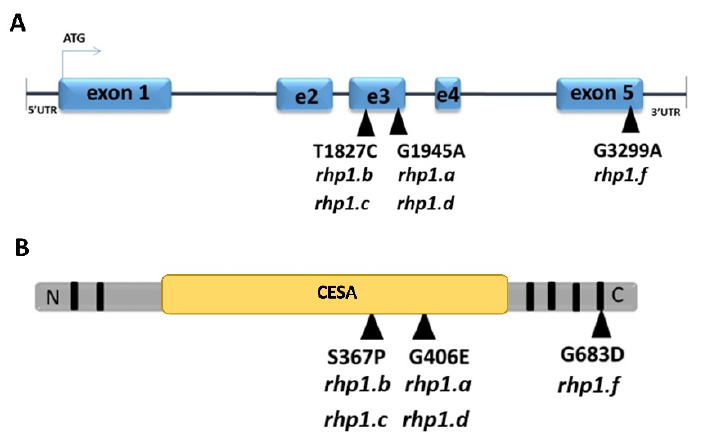
Figure 4. The location of identified mutations (black triangles) in ( A ) genomic and ( B ) protein se- quence of HvCSLC1 in allelic mutants rhp1.a , rhp1.b , rhp1.c , rhp1.d and rhp1.f . Black boxes indicate location of transmembrane domains (TDMs); CESA—cellulose synthase domain.